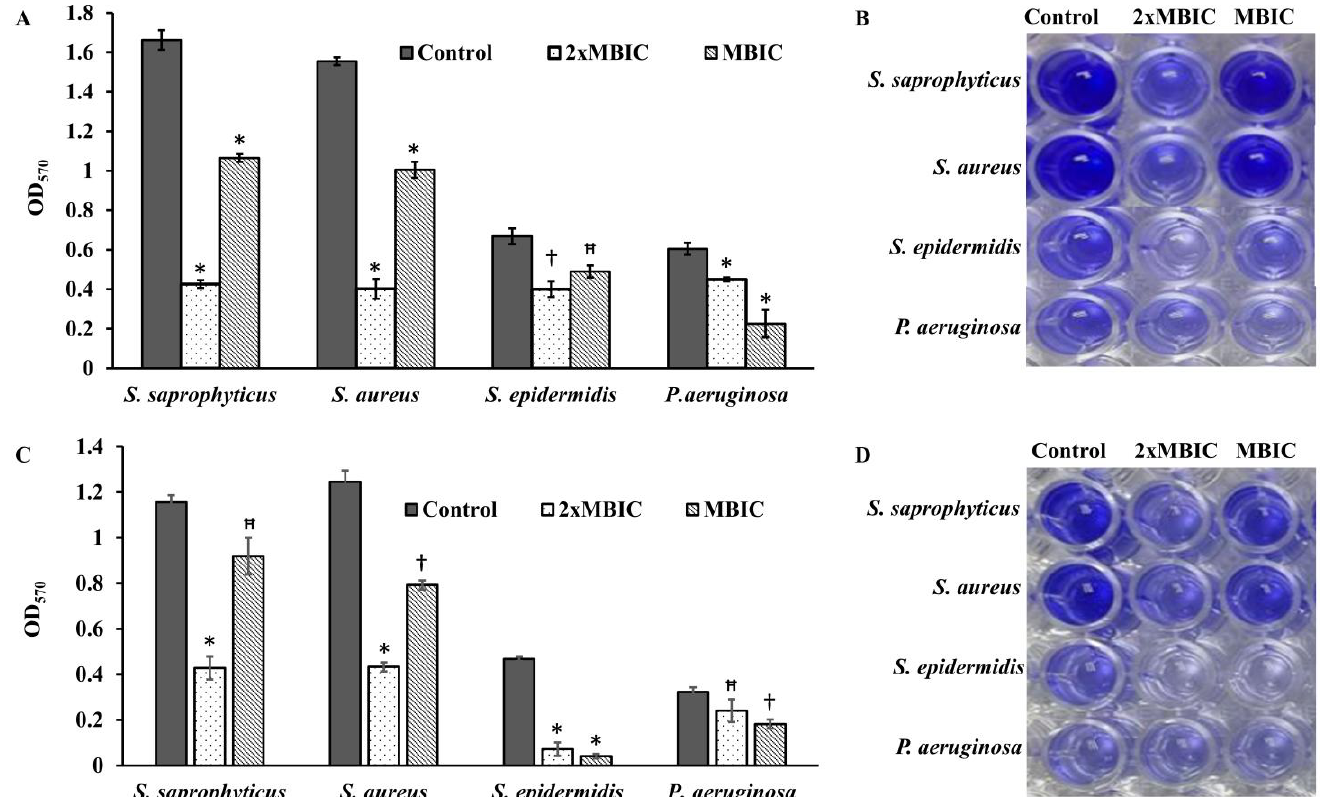
Figure 8. Mature biofilm disruption activity of β-Lap: ( A , B ) the 24 h mature biofilms were treated with β-Lap at MBIC and 2xMBIC, developed with crystal violet and quantified by absorbance at 570 nm. ( C , D ) The 48 h ultra-mature biofilms were developed and quantified under similar conditions. *: p < 0.002, †: p < 0.004, ꟸ ; p < 0.007.